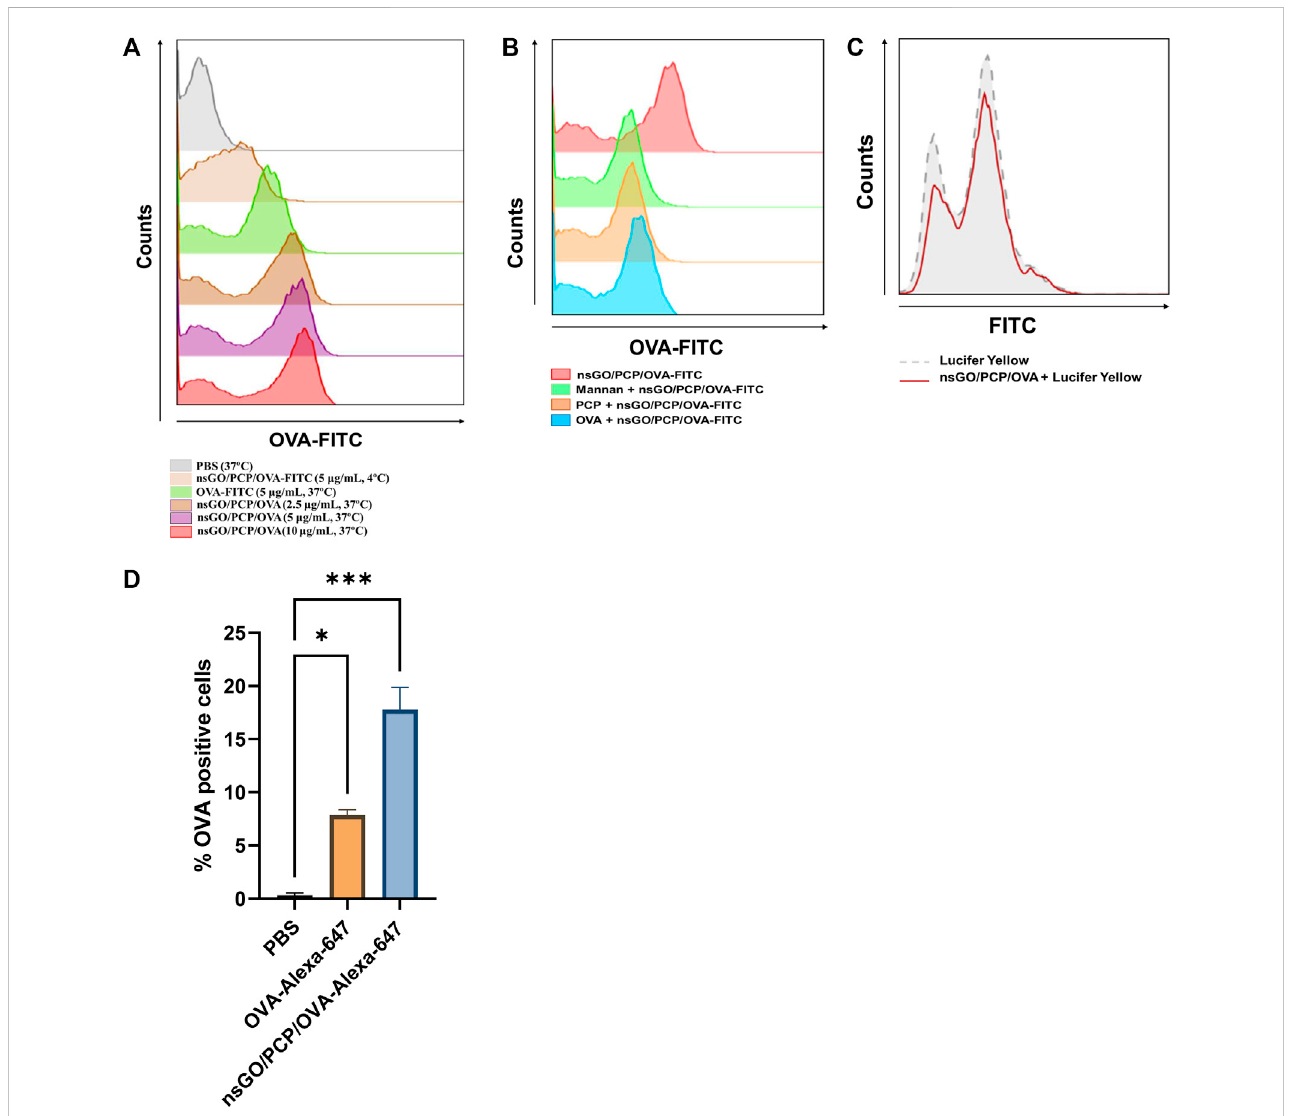
FIGURE 3 UptakeofnsGO/PCP/OVA invitro and invivo . (A) BMDCswerepre-incubatedwithPBS,OVA-FITC at5 μ g/mL,nsGO/PCP/OVA-FITCat2.5,5,10 μ g/mL at 37 ° C or nsGO/PCP/OVA-FITC at 5 μ g/mL at 4 ° C for 30 min, OVA-FITC-positive BMDCs were detected by FACS analysis. (B) BMDCs were pre-incubated withPCP,OVAormannanfor30min,cellswereculturedwithnsGO/PCP/OVA-FITC(10 μ g/mL)for45 minin37 ° CbeforeFACSanalysis. (C) BMDCswere fi rst incubated with nsGO/PCP/OVA-FITC (10 μ g/mL) for 30 min, then BMDCs were co-cultured with Lucifer Yellow for 45 min at 37 ° C before analysis of antigenuptakebyCD11c + BMDCs.TheuptakeofLuciferYellowisshowninhistograms(Greyarea:cellswithoutpre-incubationwithnsGO/PCP/OVA,redline: cells incubated with nsGO/PCP/OVA). (D) Mice were injected with PBS, OVA-Alexa 647 (20 μ g per mouse) and nsGO/PCP/OVA-Alexa 647 (20 μ g OVA per mouse) in both footpads. After 6 h, popliteal lymph nodes were isolated and prepare for single-cell suspension. Cells were then stained with anti-mouse CD11c antibody to analyze Alexa 647-positive cells using FACS analysis. Values presented are the means ± SD of three replicates (n = 3), *, p < 0.05; ***, p < 0.001 vs. PBS